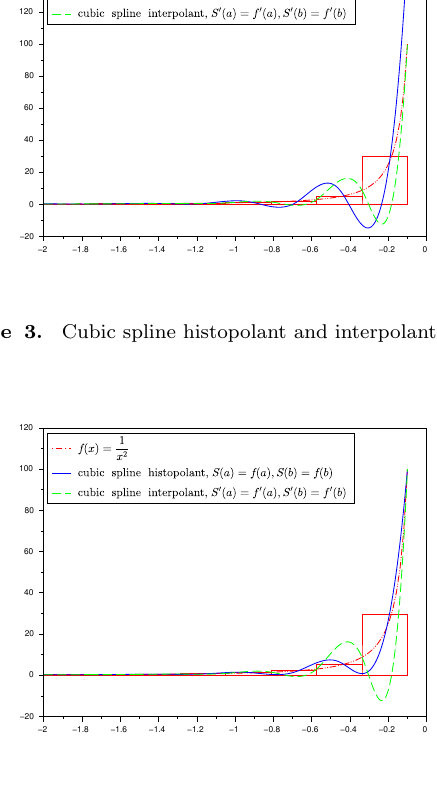
Figure 4. Cubic spline histopolant and interpolant for n =